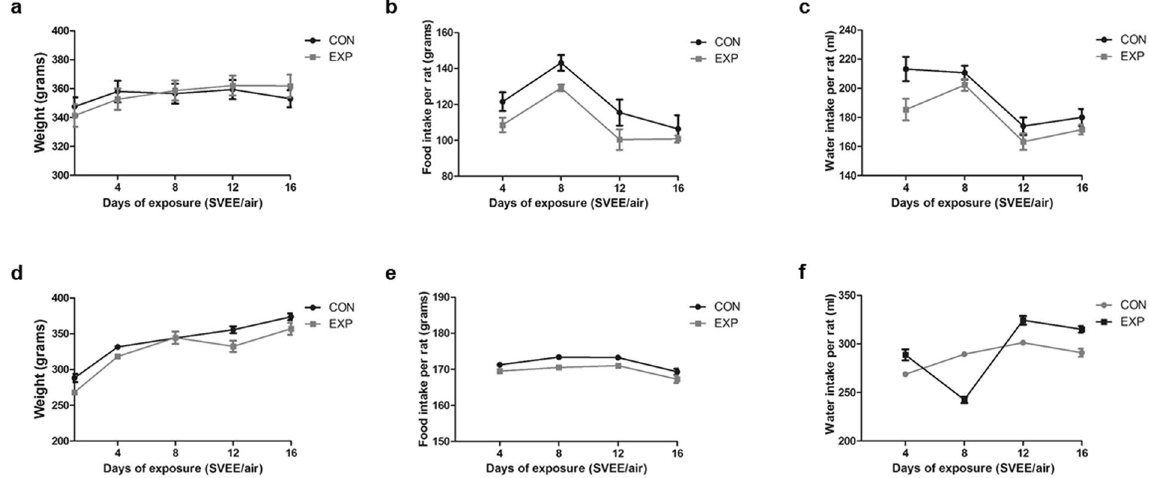
Figure 2. General body parameters following SVEE. No significant difference in weight gain, high dose brief ( a ), low dose prolonged ( d ) SVEE; food intake, high dose brief ( b ), low dose prolonged ( e ) SVEE; and water intake, high dose brief ( c ), low dose prolonged ( f ) SVEE following 2 weeks. Values are means ± SEM, n = 8 rats/ group.